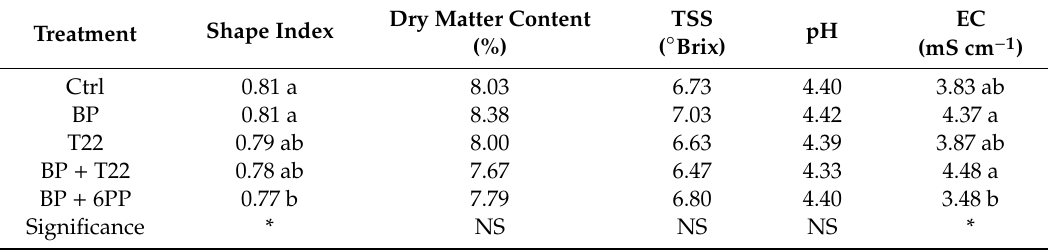
Table 1. E ff ects of treatments with Trichoderma harzianum strain T22 (T22) or biopolymer (BP) alone, or in combinations of BP + T22 or BP + 6-pentyl- α -pyrone (6PP) (BP + 6PP) on shape index, fruit dry matter content, total soluble solids (TSS) content, and juice pH and electrical conductivity (EC) of greenhouse Pixel tomato fruits. The control was not treated with biostimulants (Ctrl).